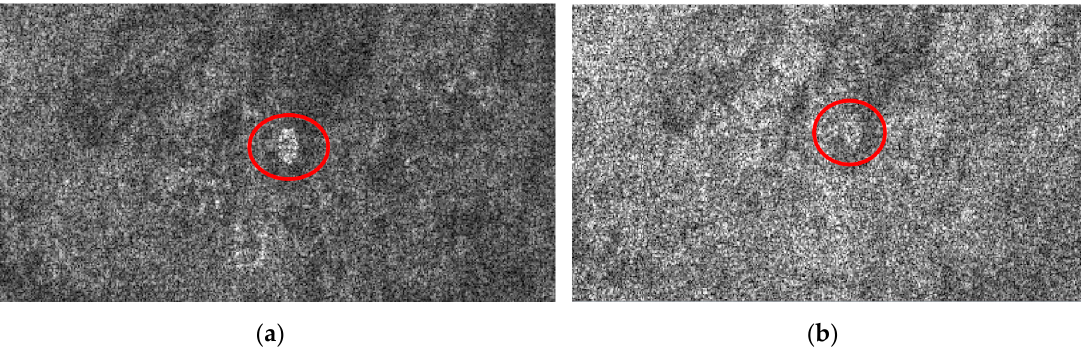
Figure 5. PALSAR-2 slant-range image of Tunnug 1: ( a ) HV and ( b ) HH . ©